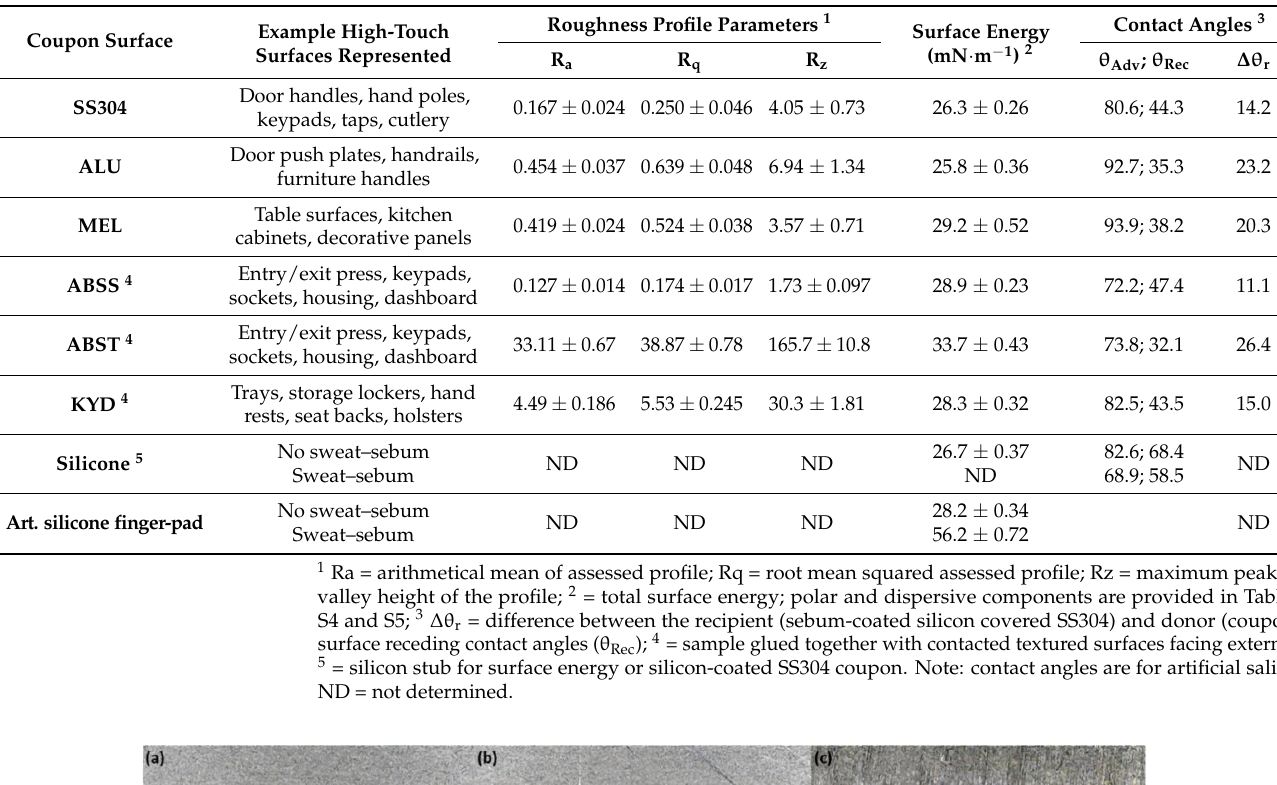
Table 1. Surface roughness and wettability characteristics of coupon surfaces.